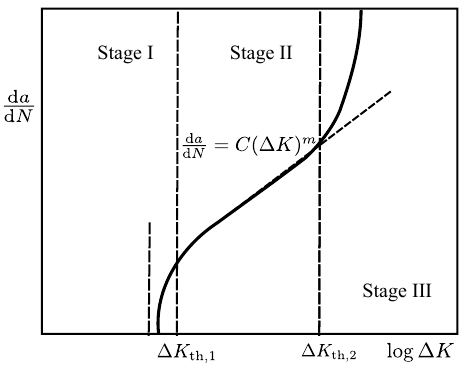
Figure 4. Fatigue crack growth